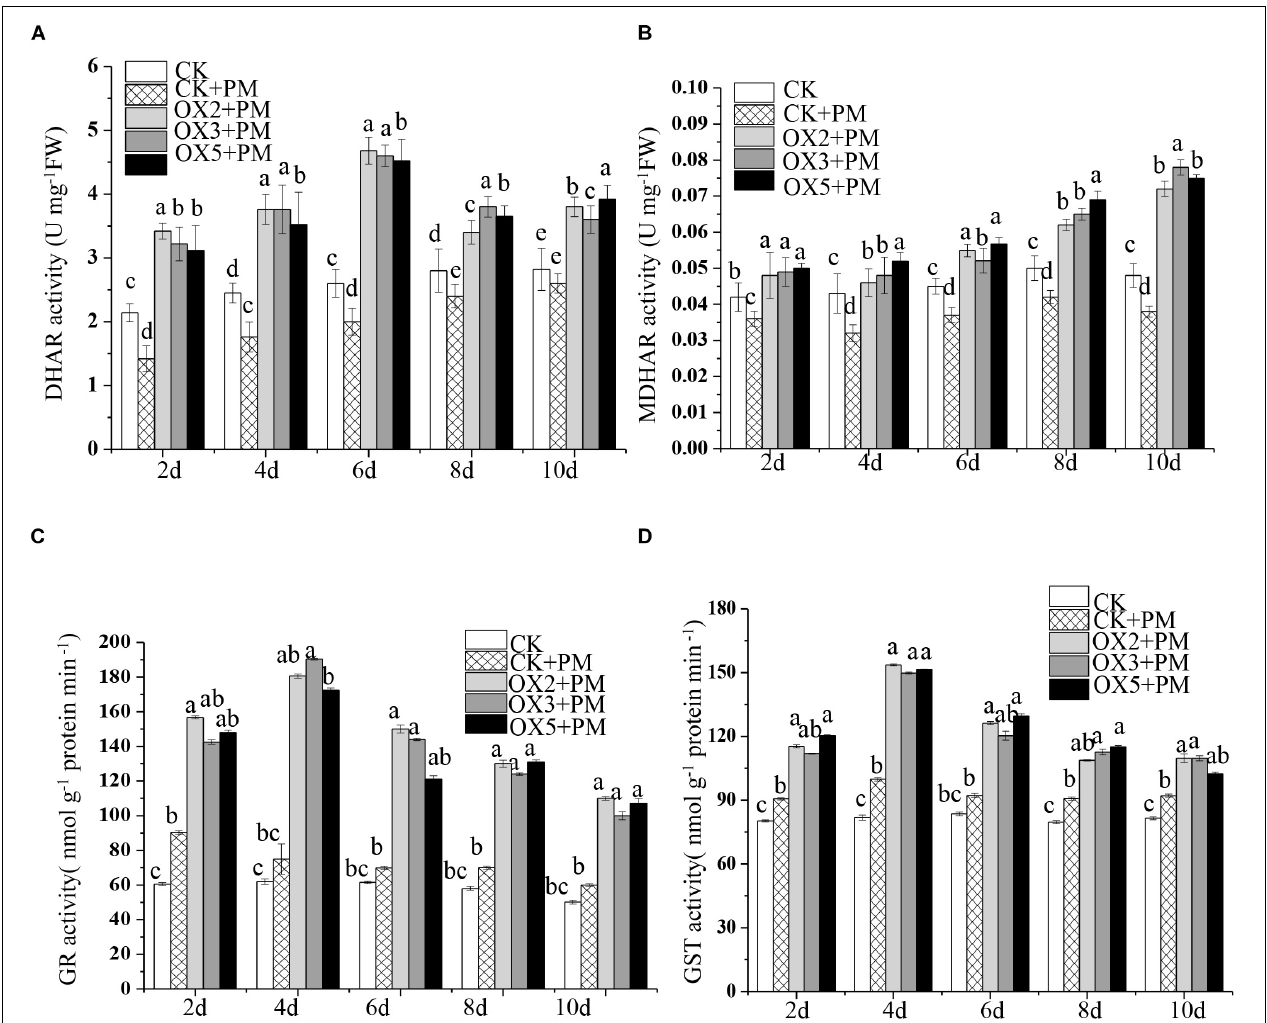
FIGURE 10 | Activity of key enzymes in AsA-GSH system in CsHMGB -overexpressing (OX) leaves of “D9320” plants. (A) DHAR activity. (B) MDHAR activity. (C) GST activity. (D) GR activity. Data are the means of three replicates with SEs, and different letters indicate a significant difference ( p < 0.05 by Tukey’s